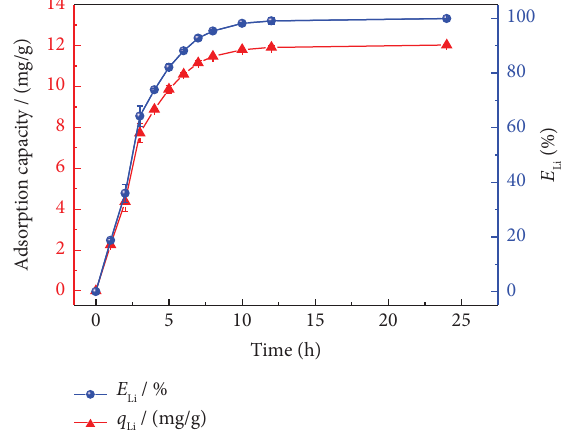
Figure 8: CMC-HTO-EGDE-ME: pH efect for adsorption from geothermal water.